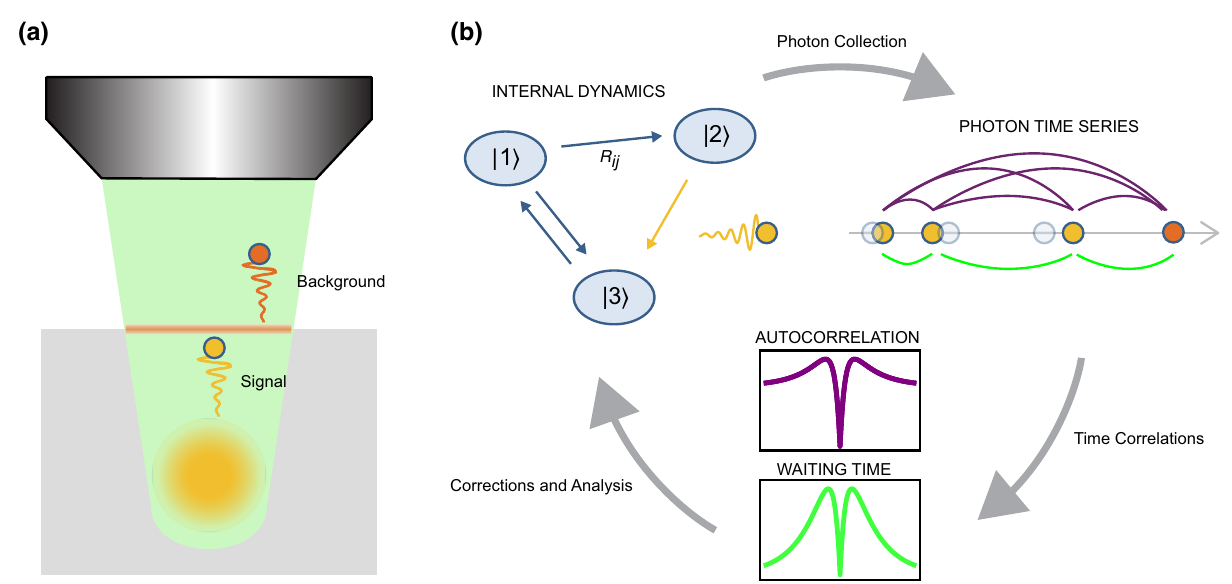
FIG. 1. An experimental overview. (a) Laser light is focused through a microscope objective onto a quantum defect in a solid-state crystal (gray block). The resulting fluorescence from the defect is emitted isotropically and collected through the objective as the signal. Background photons arising from surface fluorescence and other fluorescent defects are also collected. (b) The full process of PECS is illustrated. Starting in the upper left, excitation from a laser source causes the system to evolve between different electronic states, emitting a photon when passing through a radiative transition. The emitted photons (yellow circles) are collected into a photon time series, which includes experimental noise such as timing error, represented by light gray circles, and background photons (orange circle). Time correlations are calculated between either all photons or only subsequent photons to make up the autocorrelation or waiting-time distribution, respectively. Corrections and analysis of the photon-emission statistics help to paint a clearer picture of the internal-dynamics model of the